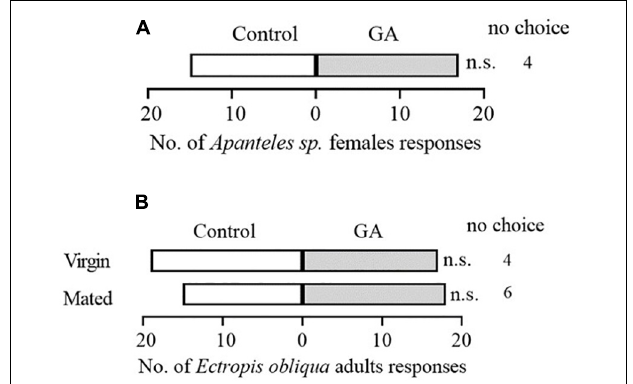
FIGURE 2 | Behavioral responses of mated Apanteles sp. female wasps to volatiles emitted from GA-treated vs. control plant (A) , and mated or virgin Ectropis obliqua female moths to volatiles emitted from GA-treated plus caterpillars feeding vs. caterpillars feeding plants (B) . Numbers refer to the number of each tested insect choosing an odor source. n > 32 per treatment. n.s. , P > 0.05, χ 2